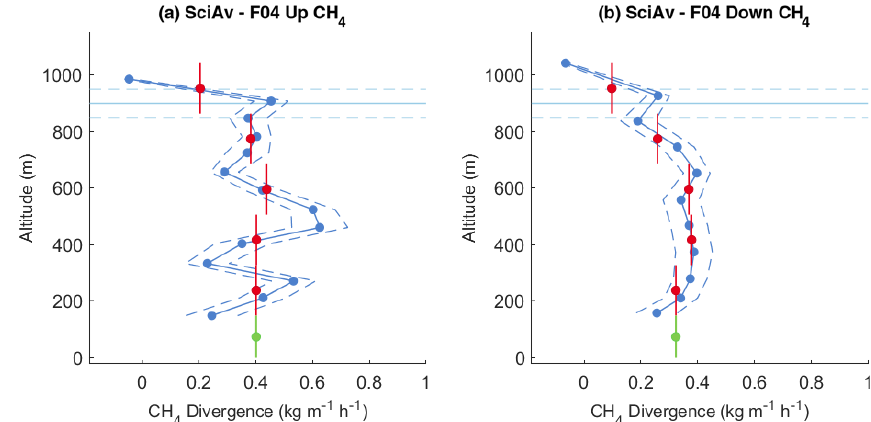
Figure 11. F04 CH 4 flux divergence profiles for the flight up (a) versus down (b) . The profile shapes differ, with a much more variable flux divergence in the up